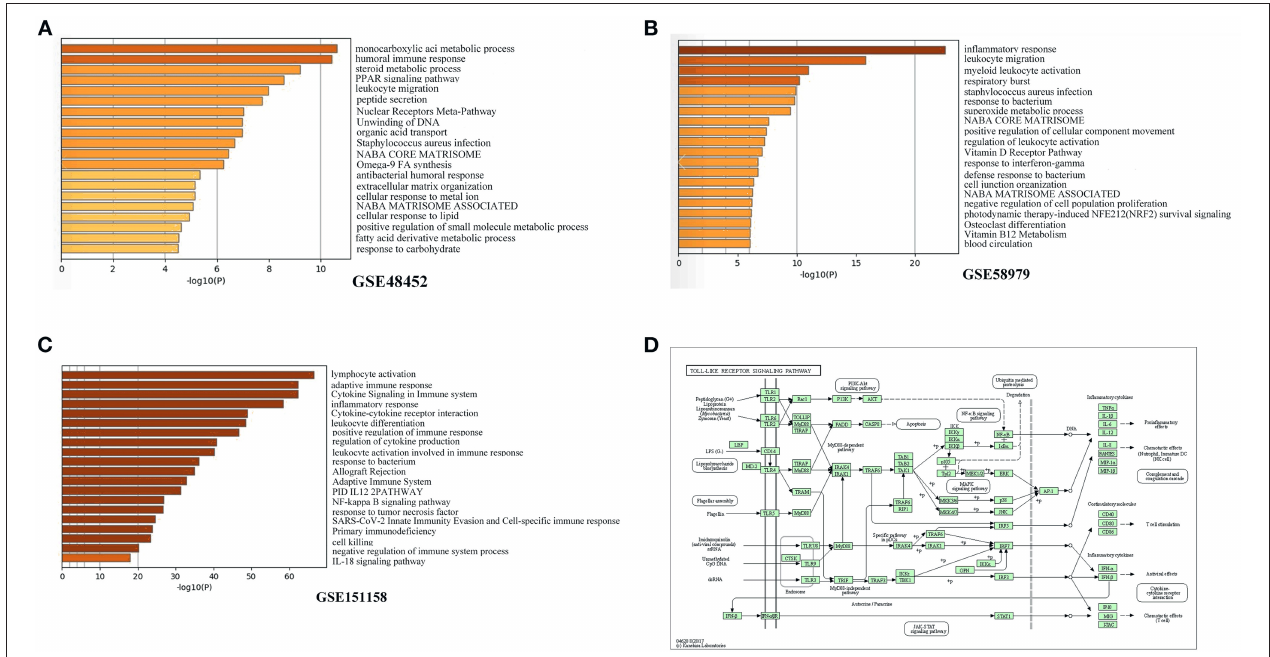
FIGURE 2 | Functional enrichment analysis of DEGs. (A–C) Top 20 biological functions according to gene ontology (GO) analysis of the two DEGs. (A) GSE48452. (B) GSE58979. (C) GSE151158. (D) KEGG functional analysis: colored map of the toll-like receptor signaling pathway.